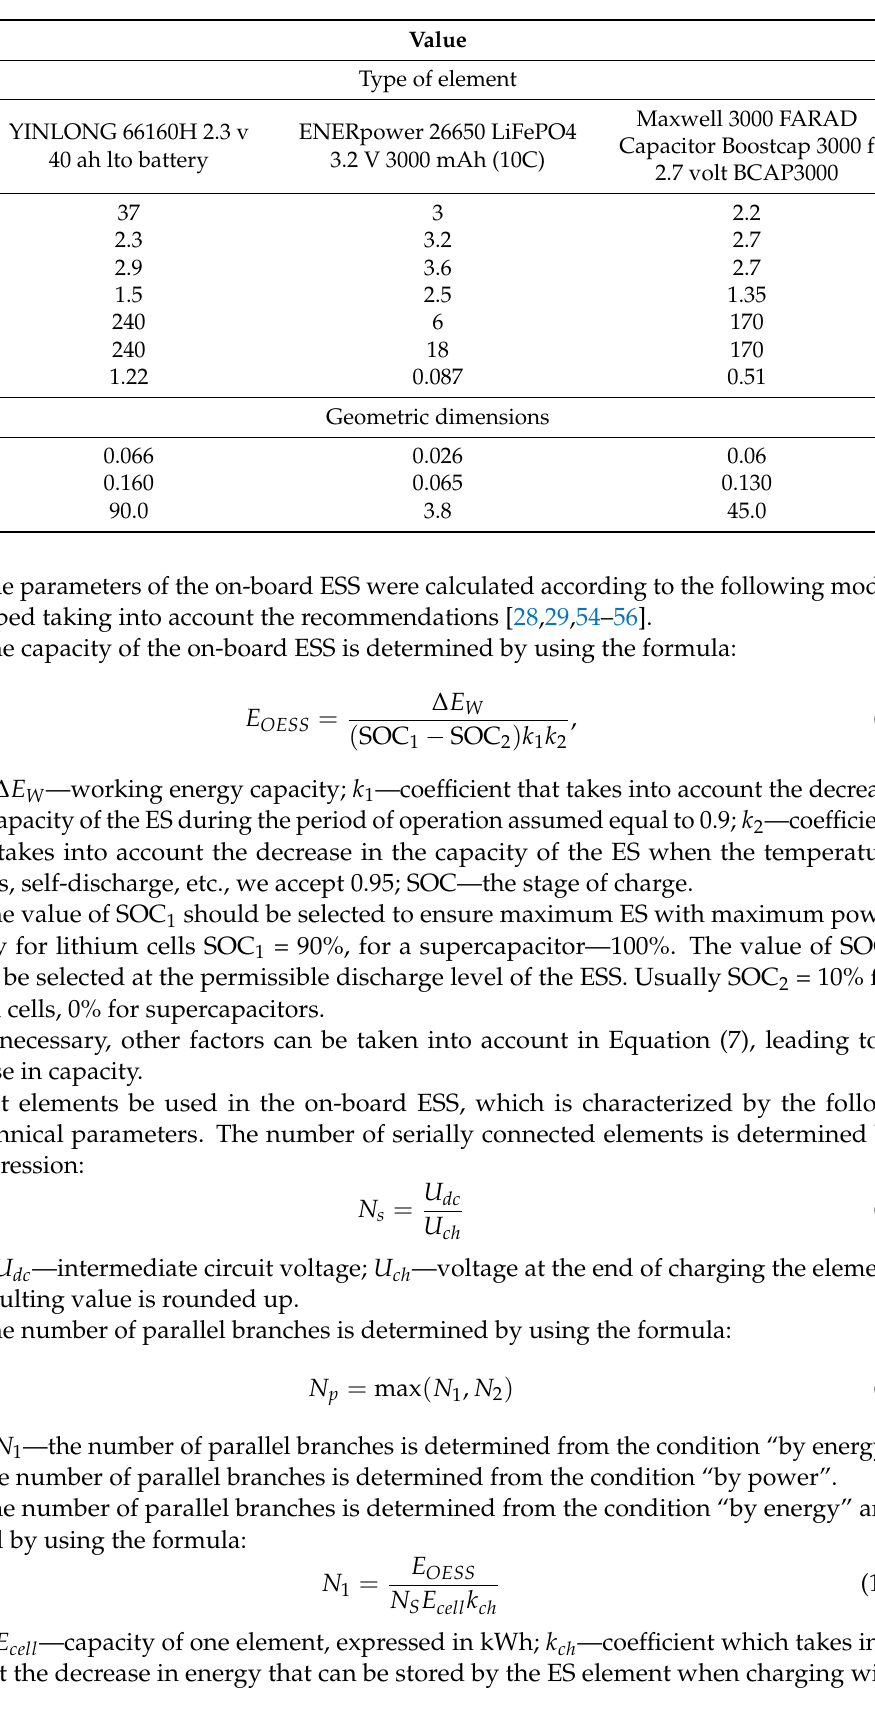
Table 1. Parameters of storage